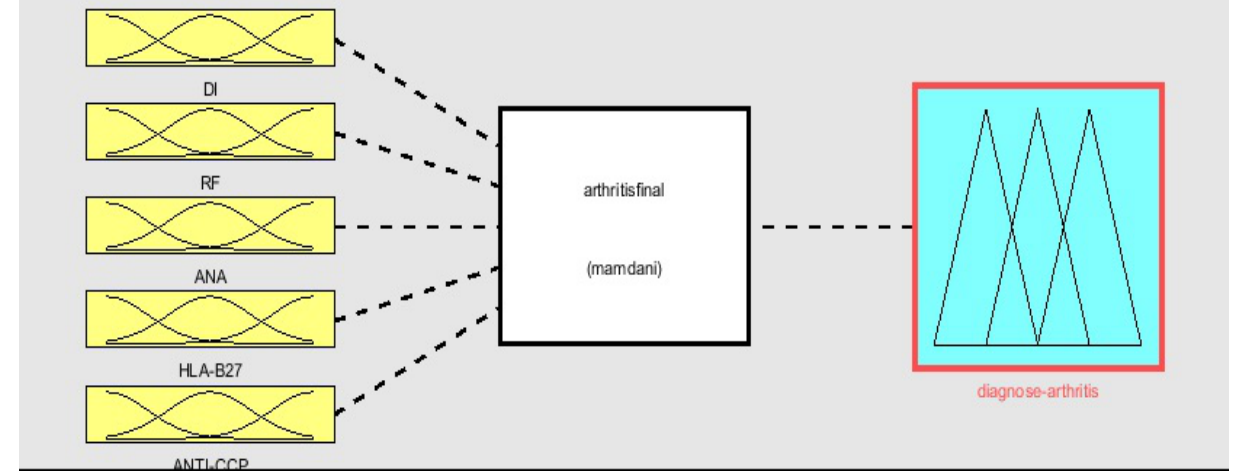
Figure 4. Layer-2 of Proposed DA-AH-MFES Expert System using MATLAB R2019a